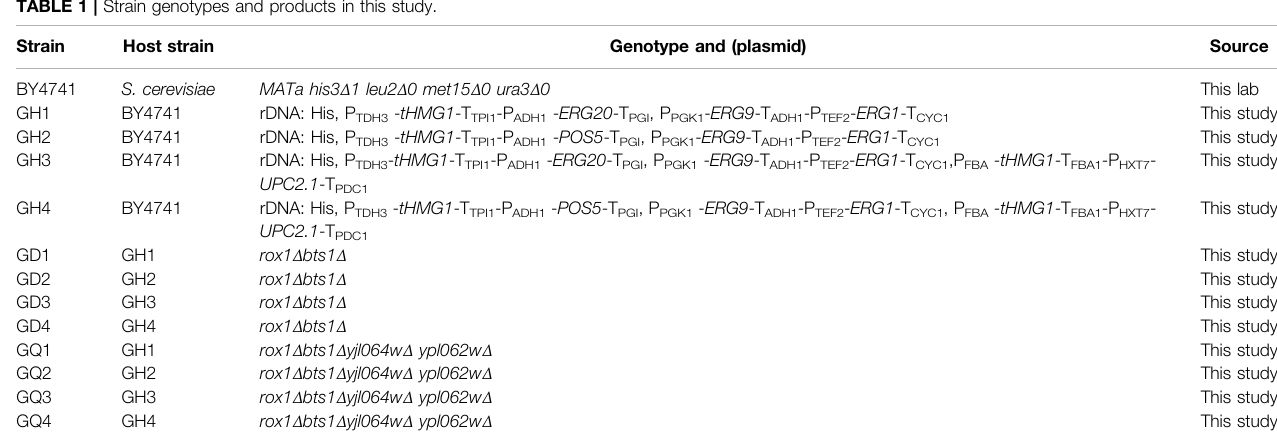
TABLE 1 | Strain genotypes and products in this